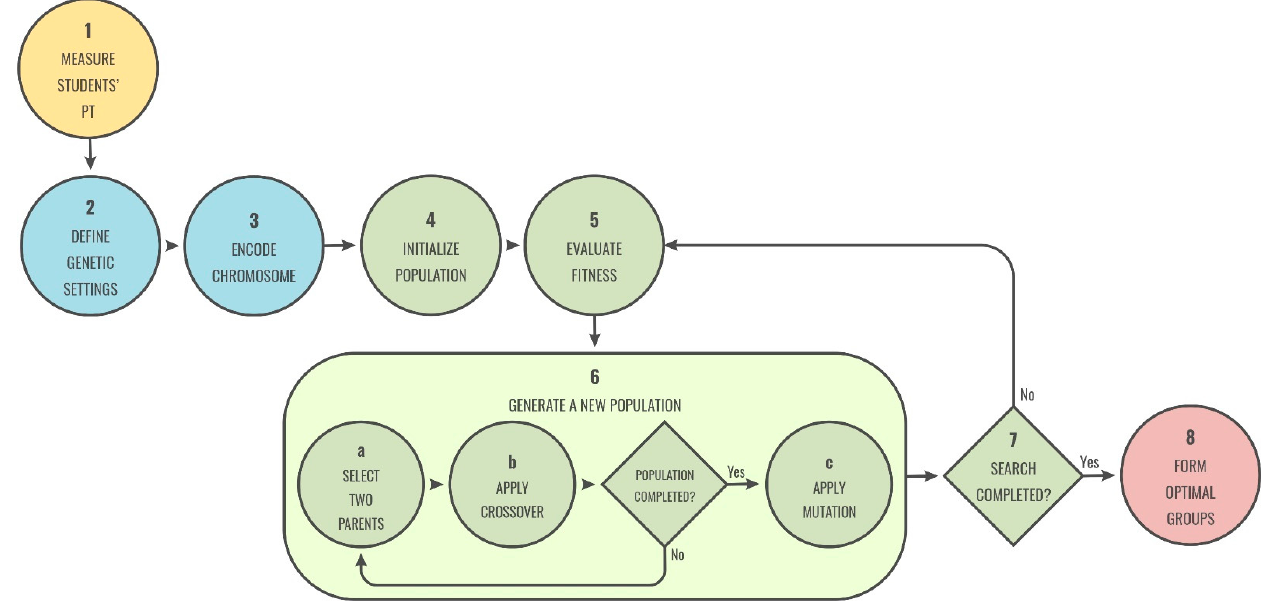
Figure 2. The main flow of the student group formation process using GA.